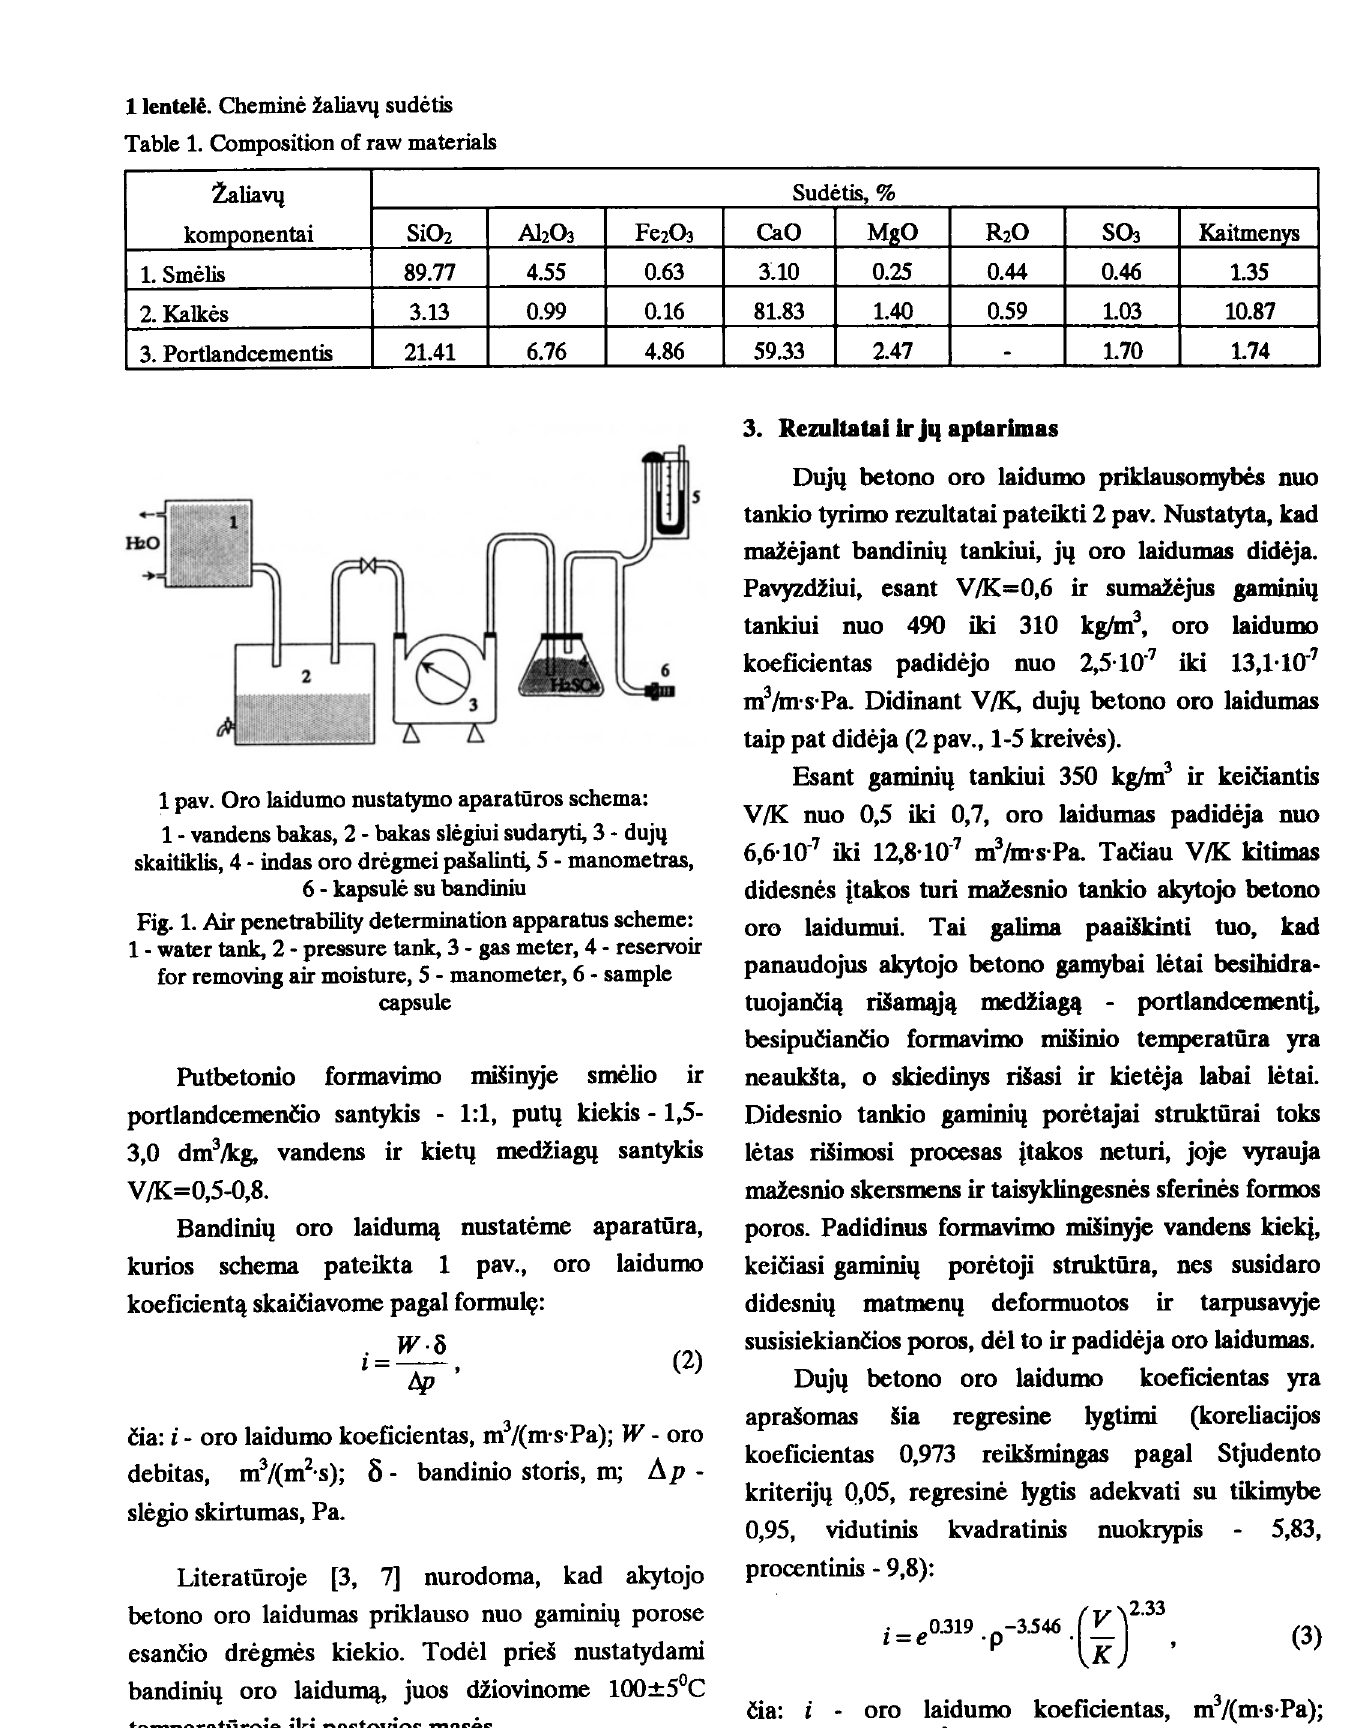
Table 1. Composition of raw materials Zaliavq